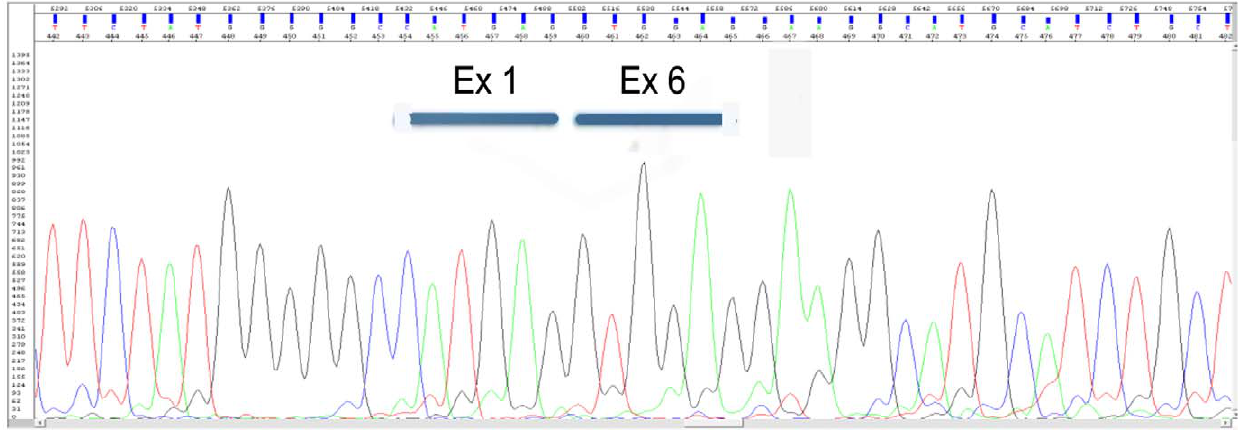
Figure 6. Analysis of the effect of c.1081 + 5G , T mutation on the mRNA splicing process. Sequencing analysis of the cDNA in patient 4 showed that this product lacks exons 2 to 5.